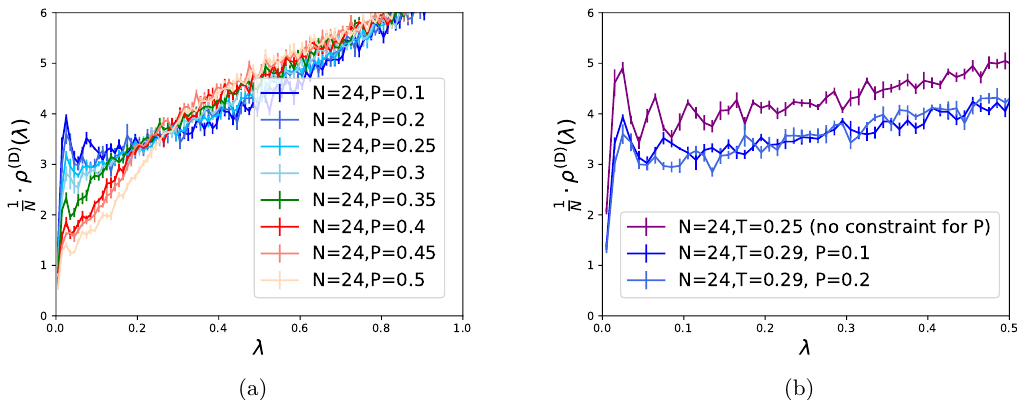
Figure 18. (a) The density of Dirac eigenvalues, ρ (D) ( λ ) , divided by N , for N = 24 , n t = 24 , T = 0 . 29 , and various P above and below the GWW point, P ’ 0 . 35 . In the partial phase, P . 0 . 35